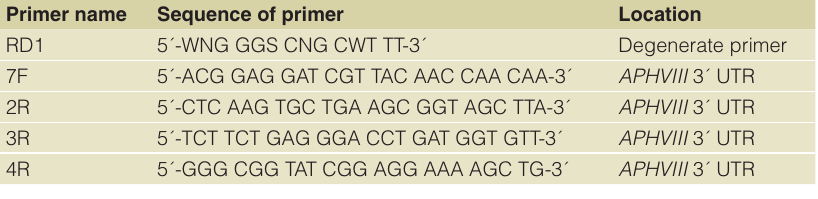
Table 1. List of primers used for TAIL (Thermal Asymmetric InterLaced) PCR, verification of TAIL PCR product and DNA sequencing. These primers were used to generate the data in Figure S2 and Figure